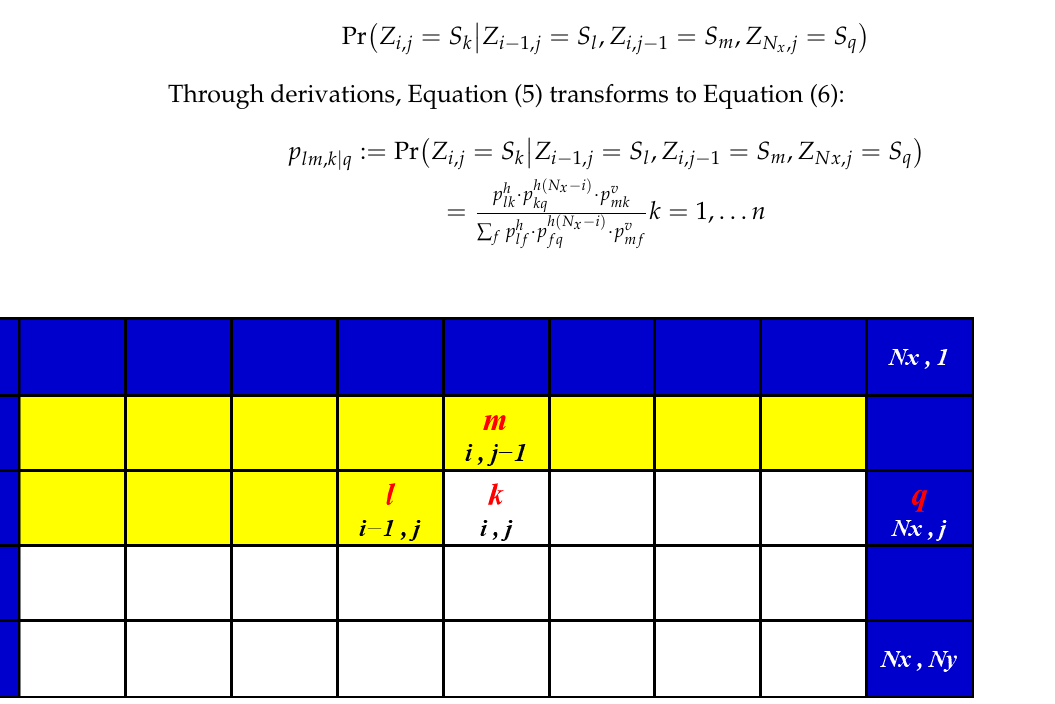
Figure 2. Two-dimensional field-numbering system in a coupled Markov chain.